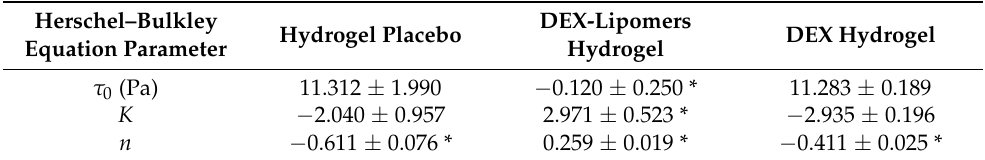
Table 6. Rheological parameters of the Herschel–Bulkley equation of hydrogel placebo, DEX hydrogel, and FD DEX-lipomers hydrogel (mean ± standard deviation). (*) denoted statistical differences p <